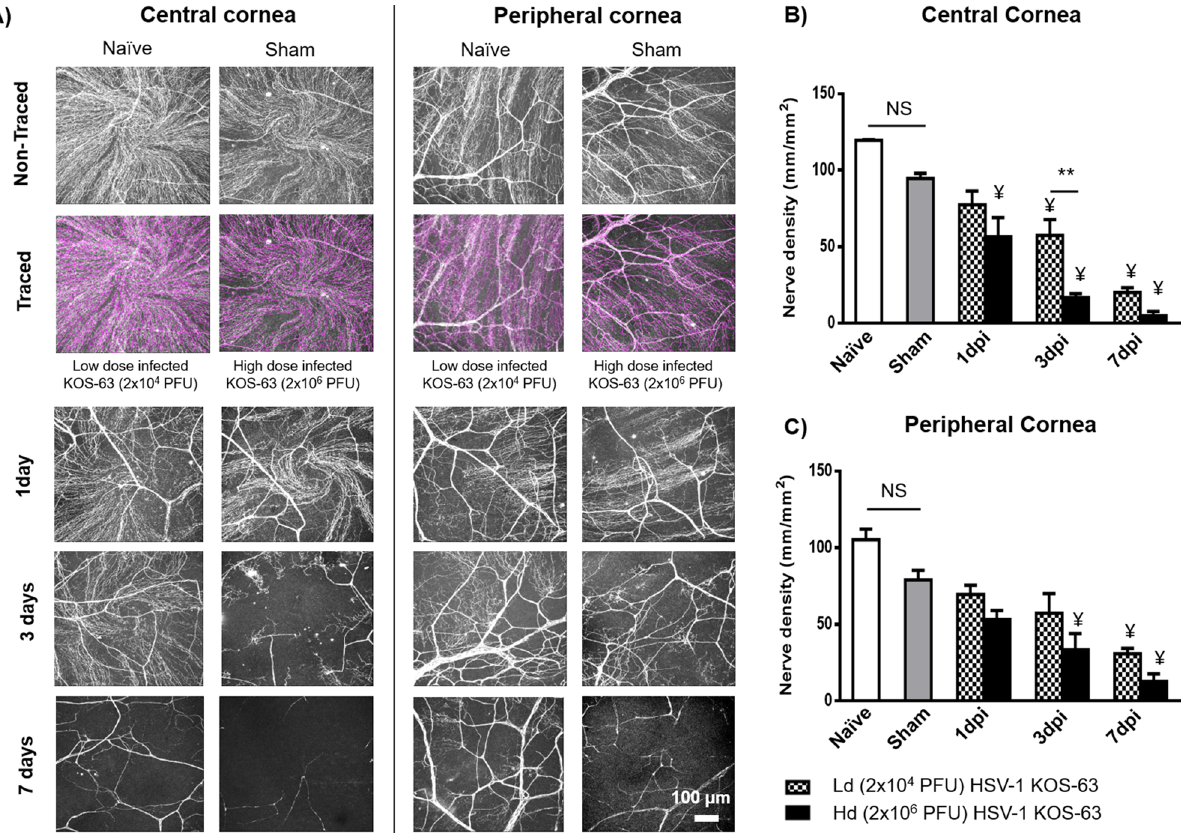
Figure 6. Corneal nerve density in the center and periphery of naïve and sham-infected corneas as well as Ld and Hd HSV-1 KOS-63-infected corneas. ( A ) Sample confocal micrographs of whole mount corneas stained with NL637 conjugated beta III tubulin antibody. There is a non-significant corneal nerve loss in the sham control group compared with naïve corneas. Sample central and peripheral corneal nerve tracing in naïve and sham-infected mice is demonstrated using NeuronJ software. Diminished corneal nerves in the infected corneas were observed at 1, 3, and 7 dpi especially in the central cornea of Hd infected mice. ( B ) Corneal nerve density (mm/mm 2 ) was calculated with NeuronJ software after tracing the nerves in whole mount confocal micrographs. ( C ) Corneal nerve density (mm/mm 2 ) in the peripheral cornea was calculated the same as central cornea. Each group is demonstrating the average of at least 3 whole mount stained corneas. Naïve and sham-infected central and peripheral corneal nerves were not significantly different although there was a trend towards more corneal nerve loss in the sham-infected group compared to the naïve mice corneas. ANOVA: p < 0.0001; * p = 0.01; ** p = 0.004 was calculated by one-way ANOVA followed by Tukey’s multiple comparison test. ¥, demonstrates the statistical significance ( p < 0.05) between the marked column and the sham-infected